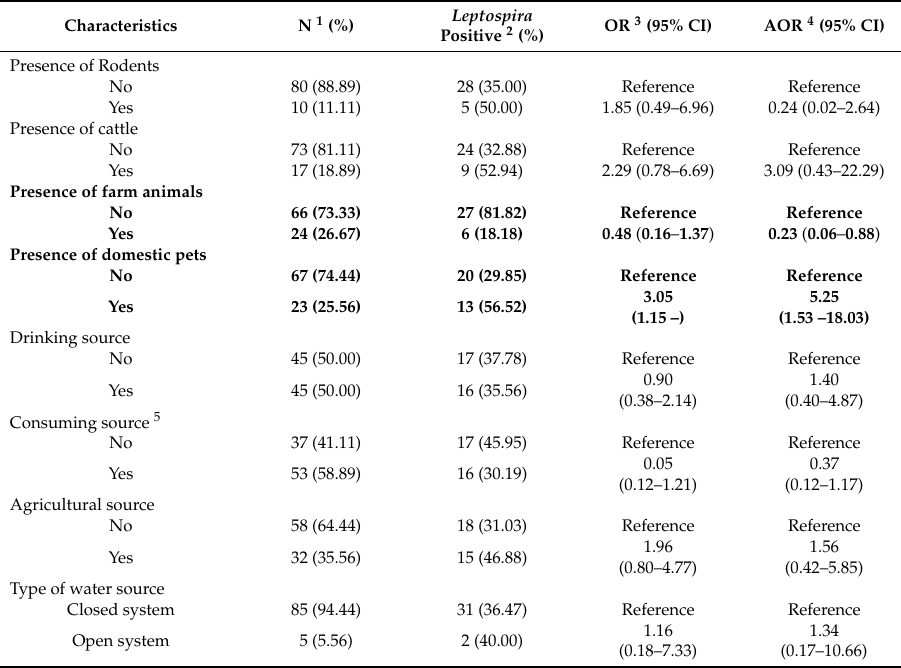
Table 4. Factors associated with Leptospira contamination of water